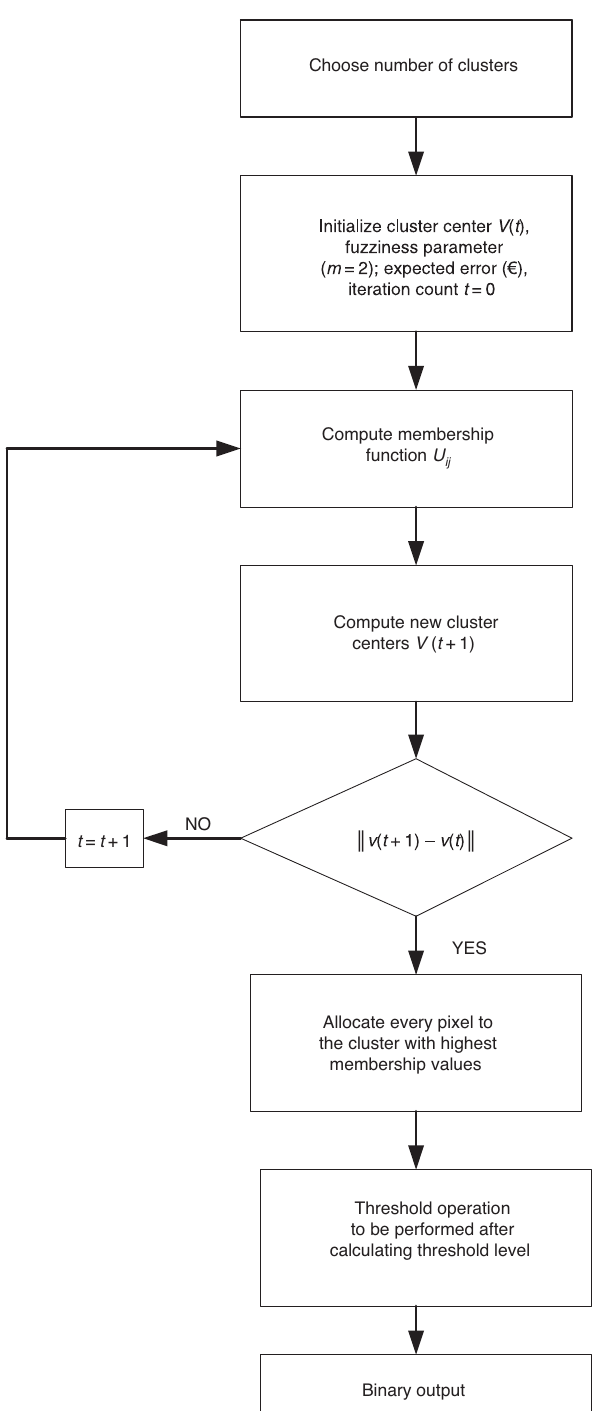
Figure 4: Flowchart of Fuzzy c-Means Threshold Clustering